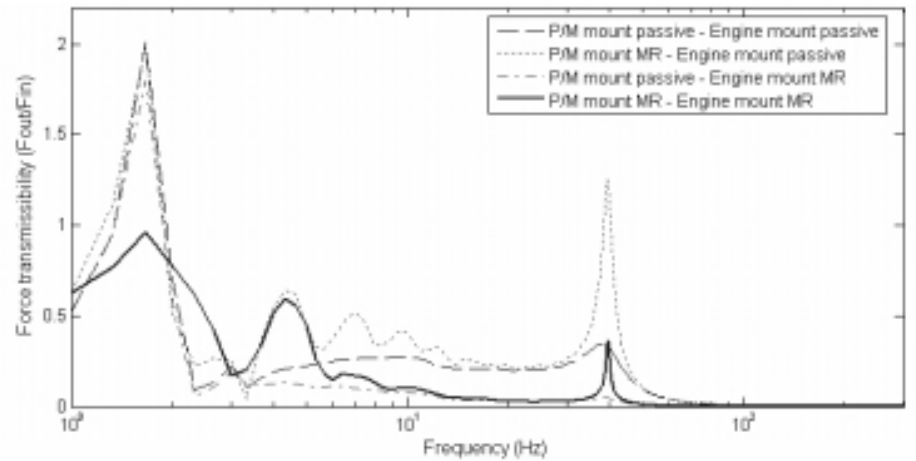
Fig. 11. Force transmissibility through the engine mounts to the